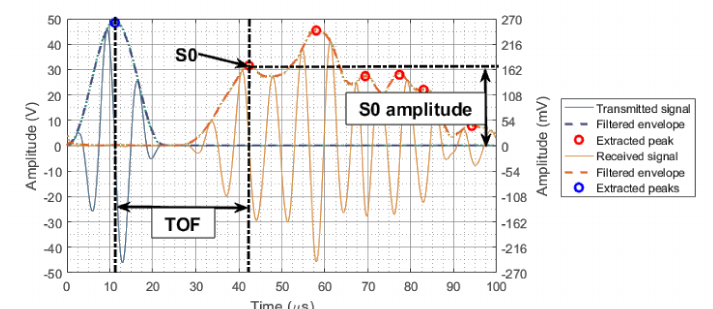
Figure 4. Determination of time of flight and amplitude for the S 0 mode at 135 kHz for a signal transmitted from ‘T8’ and received by ‘R2’.